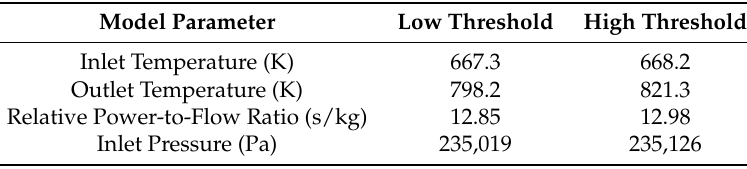
Table 1. Model parameters and discretized bin threshold values based on baseline operational